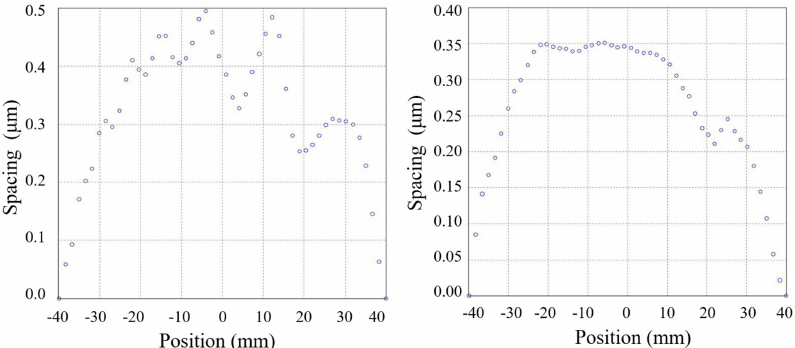
Figure 9. The surface profile of the glass substrate for the capacitive transducers array along or- thorhombic directions.